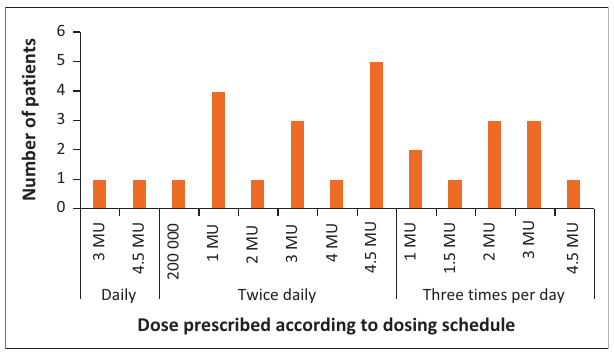
MU, million units. FIGURE 2: Doses and dosage frequency of colistin prescribed in adult patients ( n = TABLE 5: Co-administered antibiotics in paediatric and adult patients. Antibiotic Number of paediatric Number of adult patients patients ( N = 16) ( N = 27)